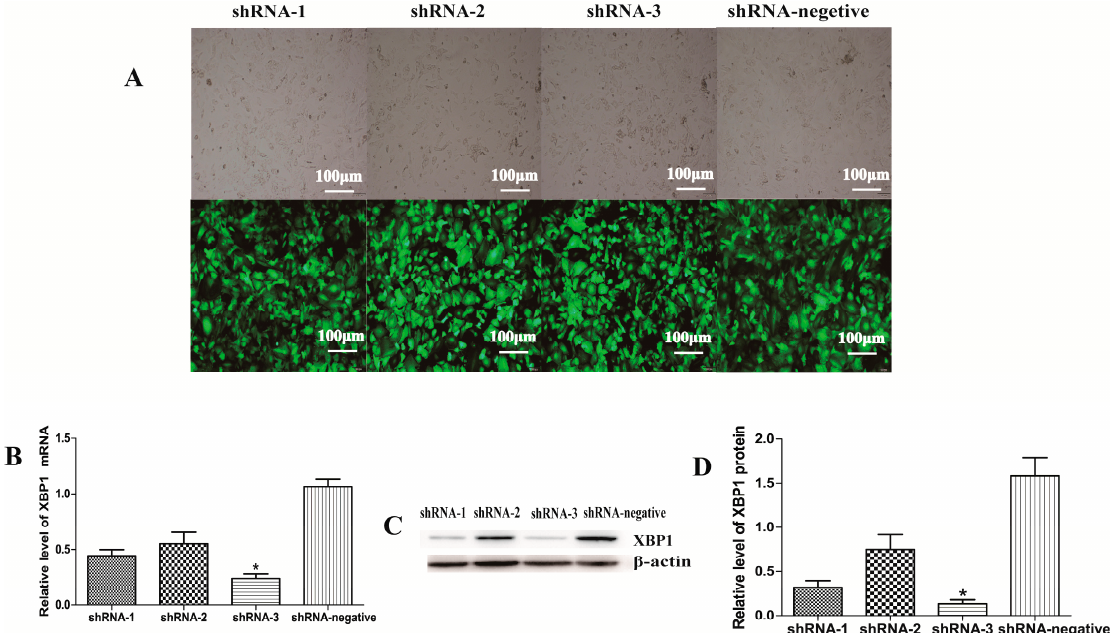
Figure 1. Effect of X-box binding protein 1 (XBP1) knockdown in mouse granulosa cells (GCs) after transduction with XBP1-shRNA lentiviruses for 48 h; ( A ) Green fluorescent protein (GFP) fluorescent images are shown to demonstrate the transfection efficiency of XBP1-shRNA; ( B ) Expression of XBP1 mRNA in mouse GCs was detected after transduction for 48 h by real-time PCR; ( C , D ) XBP1 protein expression level in mouse GCs is measured by western blot at 48 h after transduction. The analyses of the band intensity are presented as the relative ratio of XBP1 to β -actin. Data are shown as the mean ± standard error of the mean (SEM). Bars with an asterisk represent a significant difference ( p < 0.05).